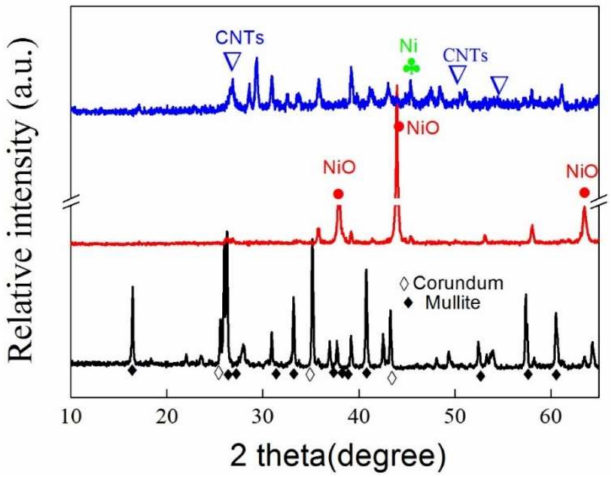
Figure 3. The X-ray diffractometer (XRD) patterns of the mullite ceramic substrate (black line), NiO catalysts on the mullite ceramic substrate (red line), and the mullite-CNT composite membrane (blue